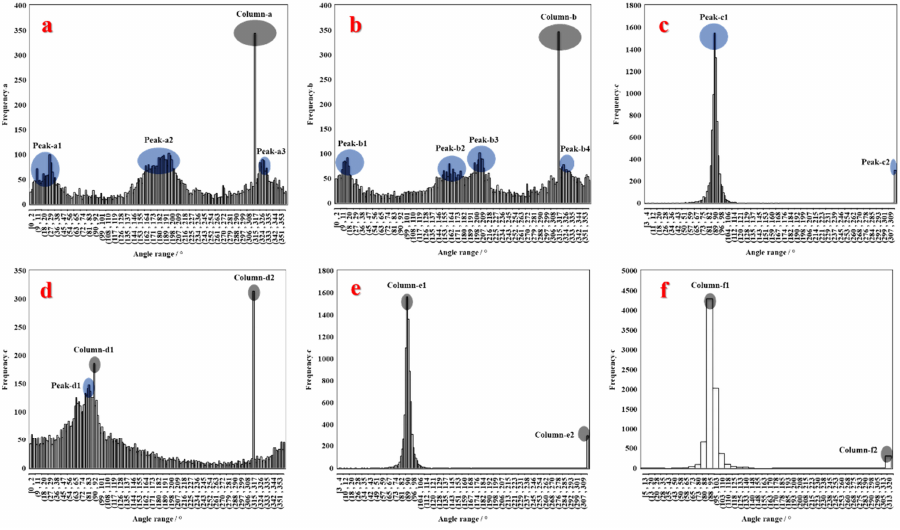
Figure 9. Simulation results of the anisotropic flow angle distribution of samples a–f.